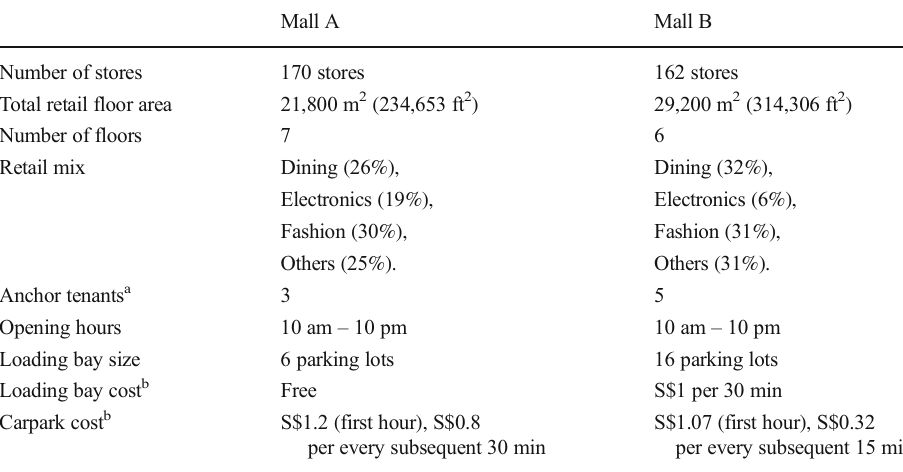
Table 1 Description of observed retail malls and their parking facilities